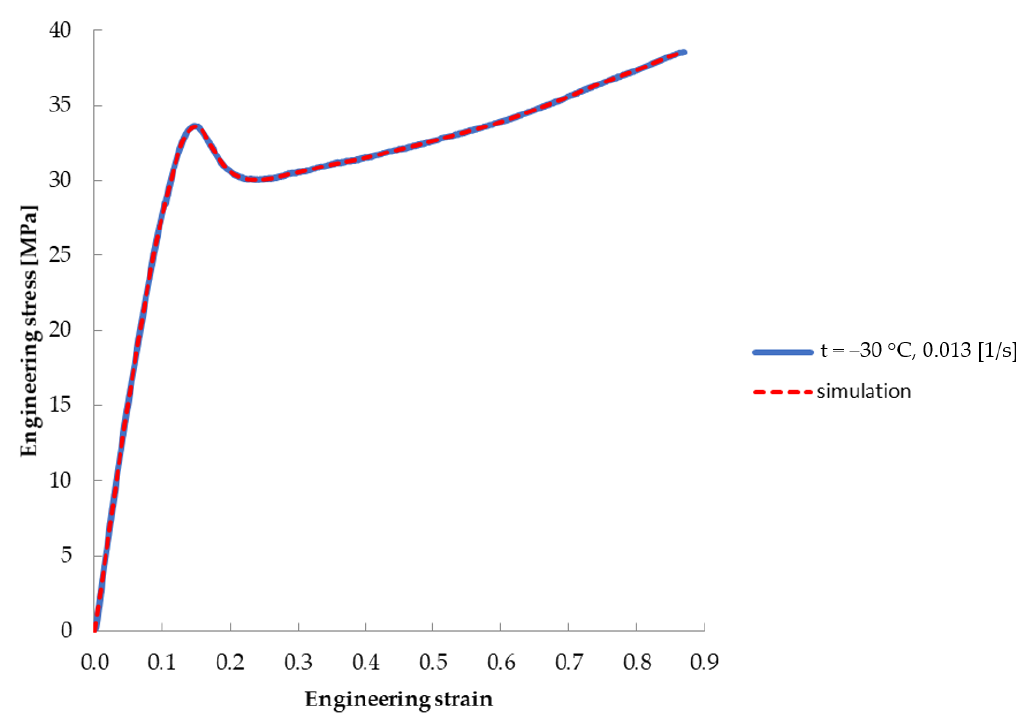
Figure 5. Comparison of test curve and FEM simulation curve (t = − 30 °C).